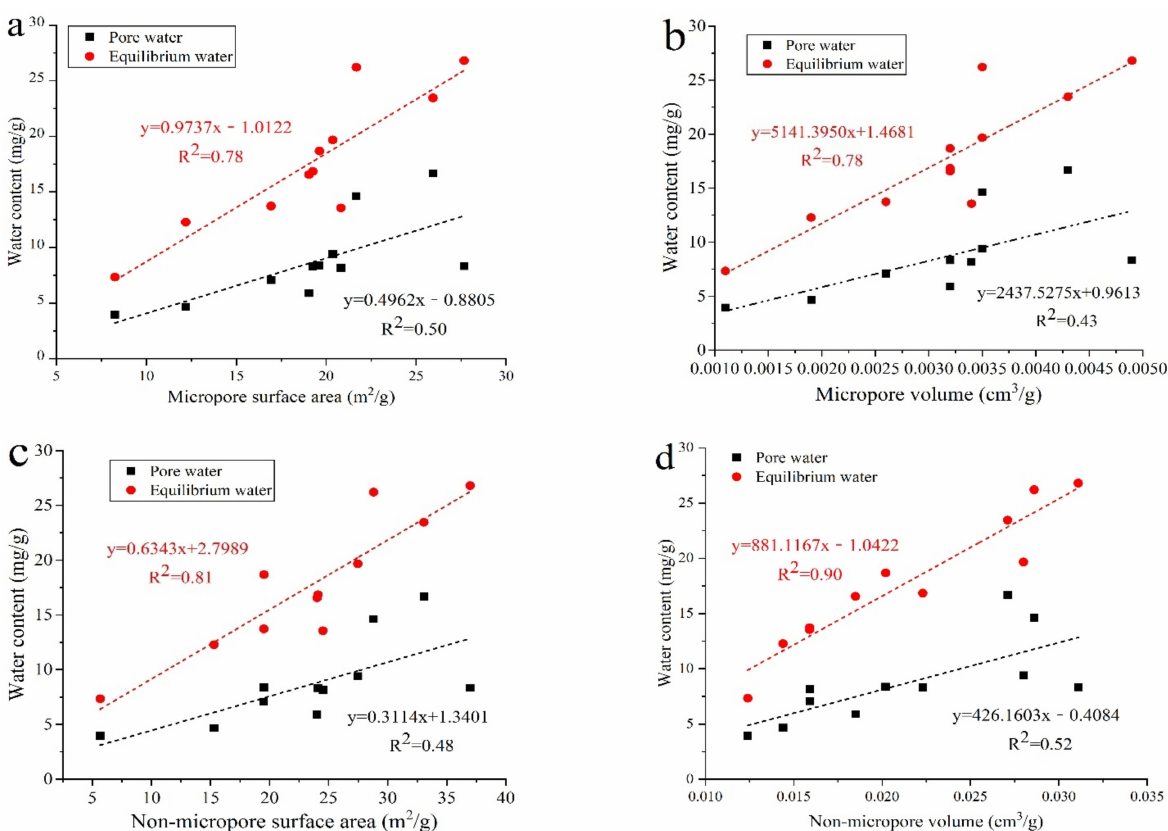
Figure 8. Correlations of pore water contents with pore structures for the studied deep shale samples in the Luzhou Block. ( a ) the relationship between water content with micropore surface area; ( b ) the relationship between water content with micropore volume; ( c ) the relationship between water content with non-micropore surface area; ( d ) the relationship between water content with non-micropore surface